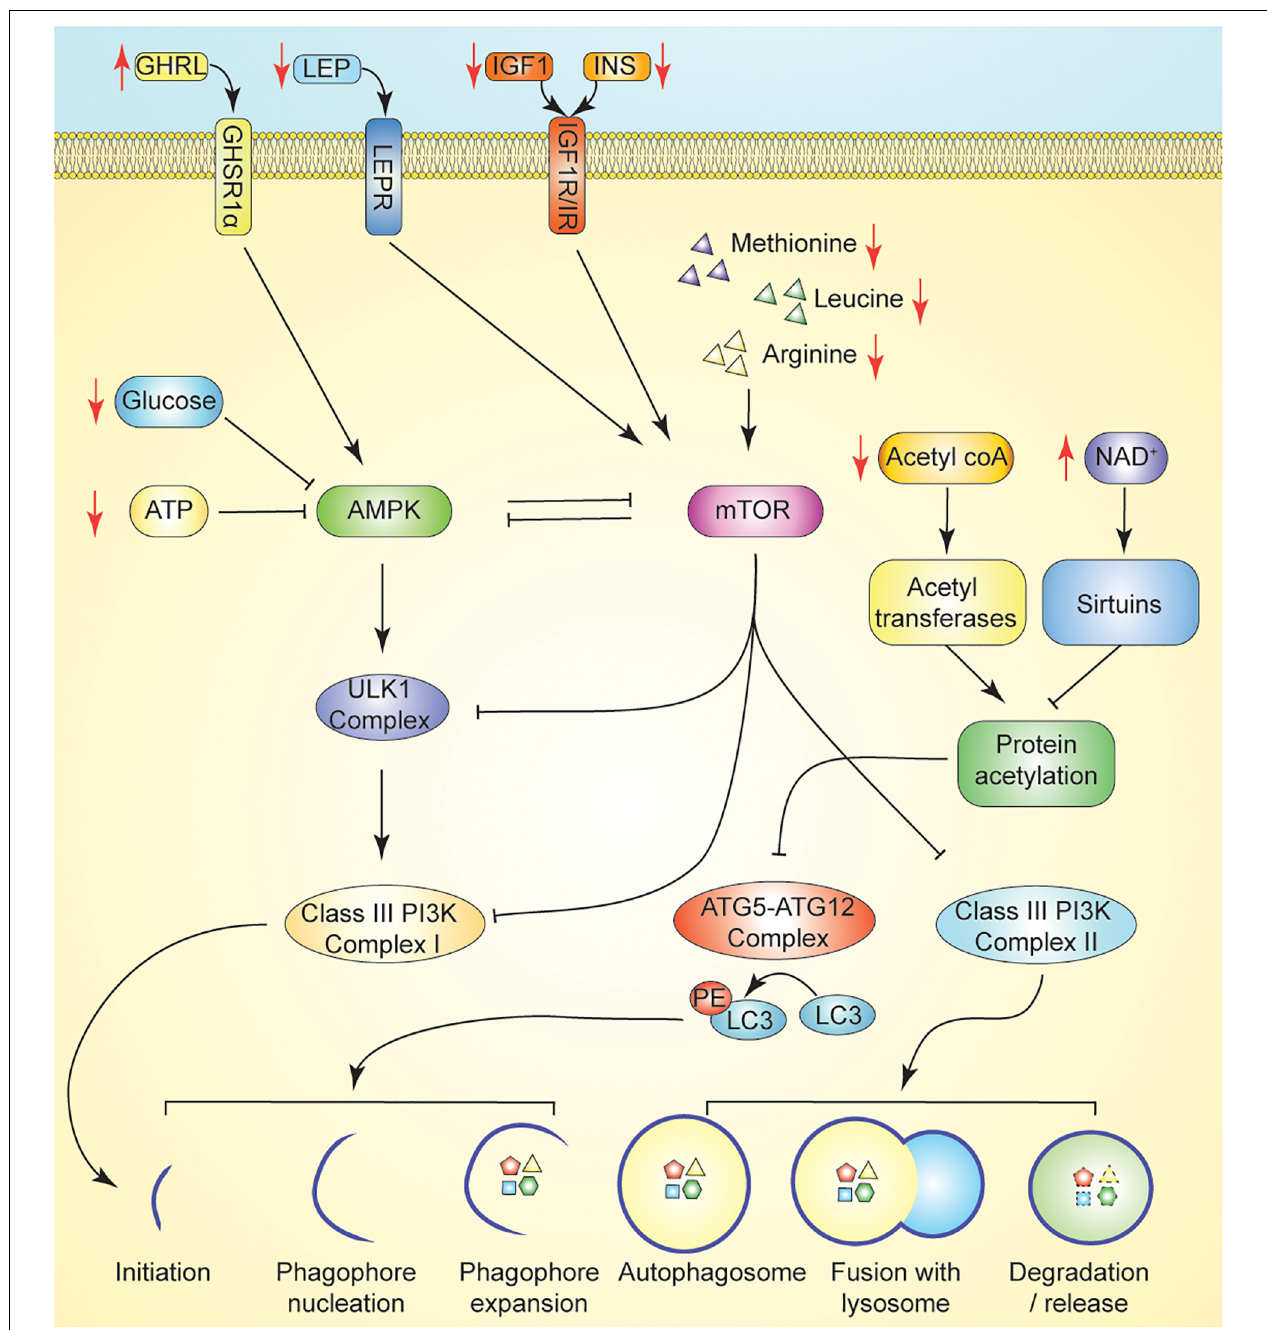
FIGURE 2 | Promotion of autophagy through nutrient or energy restriction. Caloric restriction (CR) suppresses insulin, IGF1, and leptin, each of which suppress autophagy via activation of mTOR following binding to their cognate receptor. Induction of ghrelin by CR promotes activation of AMPK to promote autophagy. Dietary energy modulation by CR limits availability of key nutrient regulators of autophagy including amino acids and glucose. In CR, AMPK signaling is induced in response to reduced ATP and/or glucose concentrations. ATG5-ATG12 complex activity is regulated by the availability of acetyl-coA and the activity of deacetylases. In CR, reduced acetyl-coA limits protein acetylation by reducing substrate availability for acetyltransferases. CR induced increase in NAD + levels promote the activity of sirtuins. Key: Black lines reflect regulation at basal states; Black arrows reflect activation, while black T bars reflect inhibition. Red arrows reflect changes in hormone/metabolite availability induced by fasting which may modulate